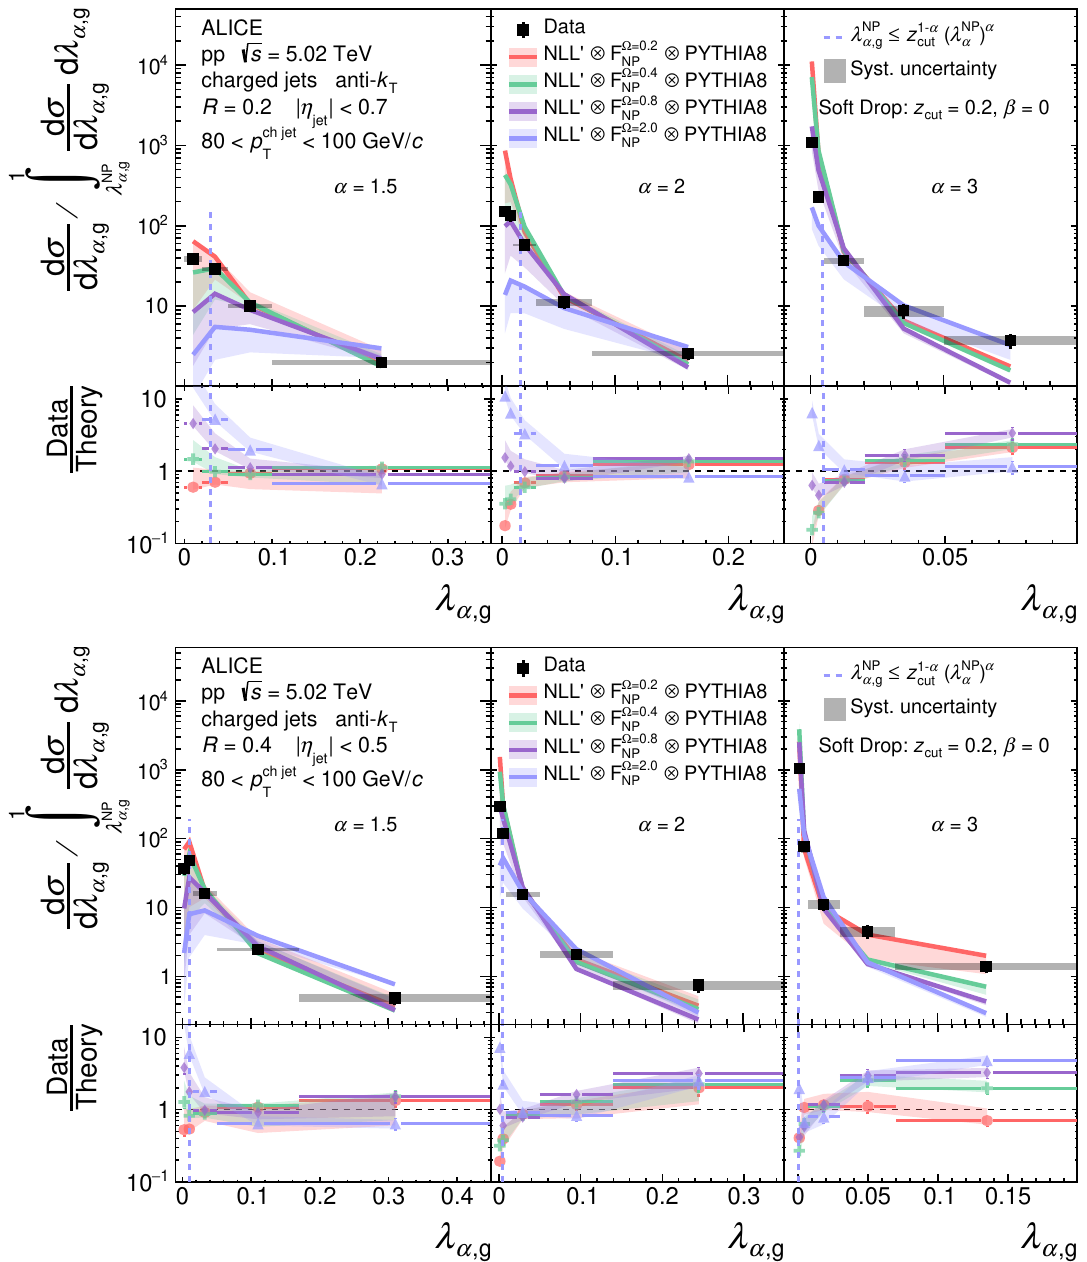
Figure 14 . Comparison of groomed jet angularities λ α, g in pp collisions for R = 0 . 2 (top) and R = 0 . 4 (bottom) to analytical NLL 0 predictions using F ( k ) convolution in the range 80 < p ch jet GeV /c . The distributions are normalized such that the integral of the perturbative region defined by λ α, g > λ NP (to the right of the dashed vertical line) is unity. Divided bins are placed into the α, g left (NP)